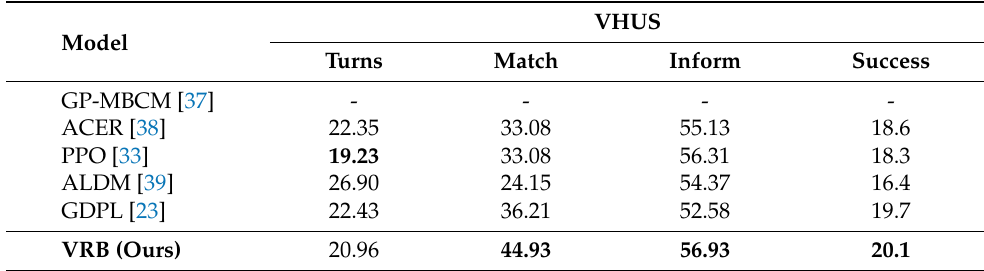
Table 3. Results on VHUS-based user